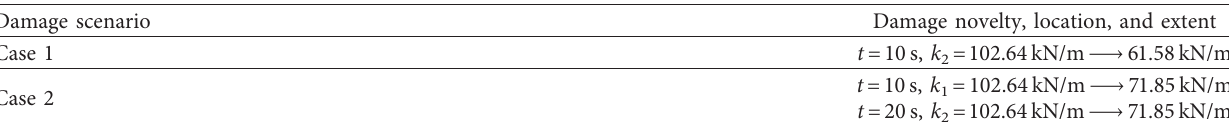
Figure 11: Original acceleration responses of the simulated structure under Kobe earthquake wave. (a) Case 1. (b) Case 2. Table 9: Damage